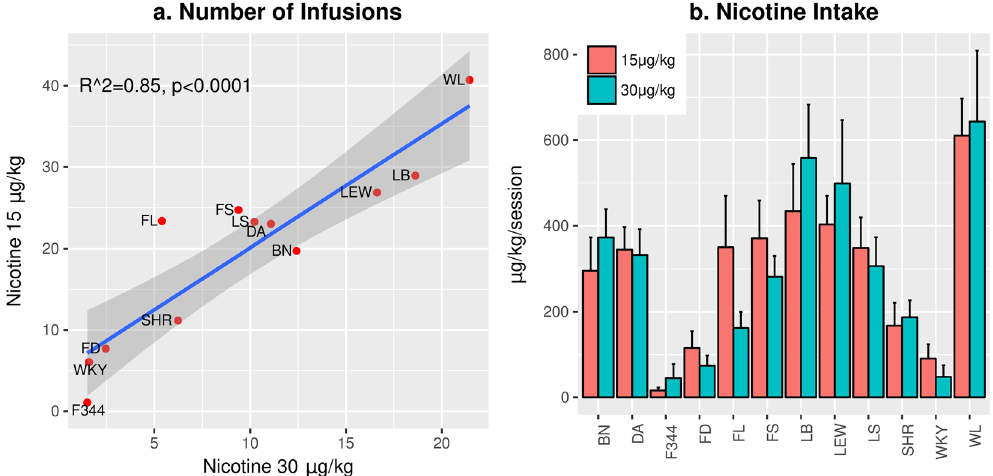
Figure 3. Average nicotine intake during the last three IVSA sessions. The number of nicotine infusions was highly correlated when two different doses were tested ( a ). The gray area represents the 95% confidence interval of the linear model. When compared to the 30 μ g/kg/inf dose, the number of infusions almost doubled across the strains when 15 μ g/kg/inf was used. As a result, the amount of nicotine obtained was very similar between the two doses ( b ). Three-way repeated measures ANOVA found there was a significant effect of strain on nicotine intake (F